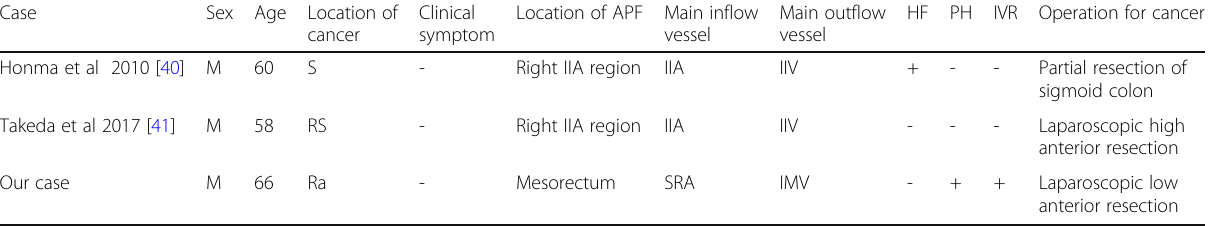
Clinical Location of APF Main inflow cancer symptom